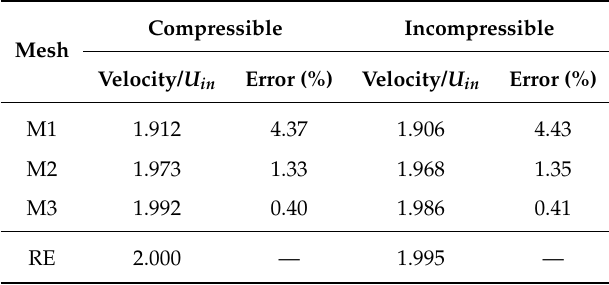
Table 6. Maximum velocity values for the mesh refinement study for both compressible and incompressible formulations, Richardson’s extrapolation (RE), and the relative errors.